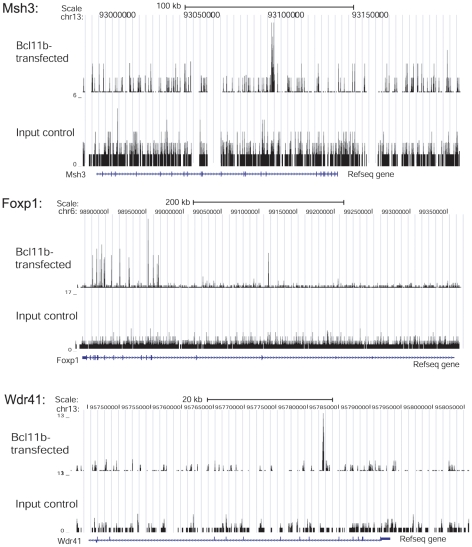
ChIP-seq binding patterns for Bcl11b target genes Msh3, Foxp1 and Wdr41.The number of tags reflecting the ChIP enrichments is plotted on the y axis and chromosomal coordinates are shown on the x axis. RefSeq genes are in the orientation indicated by arrows on the gene representation. Enriched peaks have the following coordinates: Msh3 coordinates: chr13: 93085721–93085950; Foxp1 coordinates: chr6: 99112792–99113024; Wdr41 coordinates: chr13: 95782433–95782649.